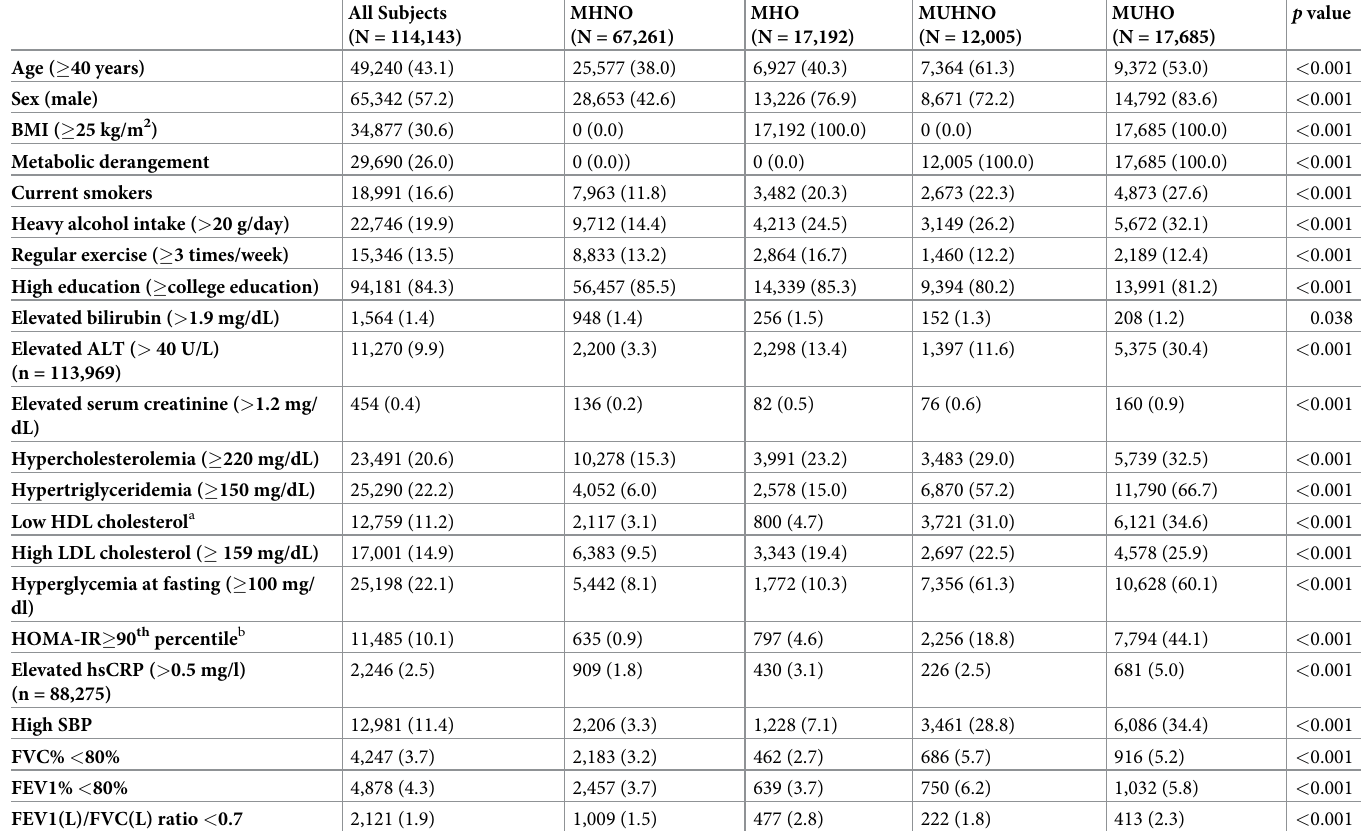
Table 3. Comparisons of demographic and clinical parameters according to metabolic health and obesity status.